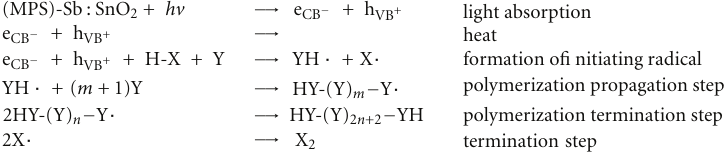
Scheme 4: The photocatalytic radical polymerization of (meth)acrylate C = C bonds initiated by the Sb:SnO 2 particles. (MPS)-Sb:SnO 2 means the Sb :SnO 2 particles grafted or not grafted with MPS; Y is PEGDA 575 monomer, grafted MPS, and/or MPS oligomer (Scheme 2). H-X is a hydrogen donor.